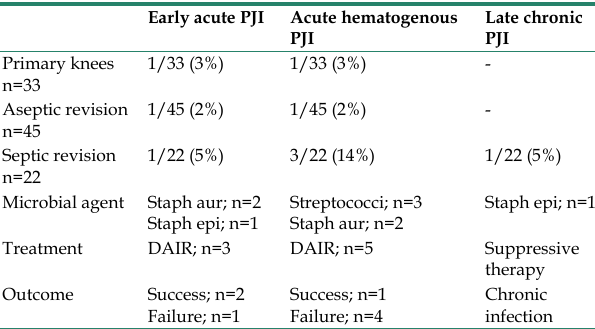
Table 4. Overview of